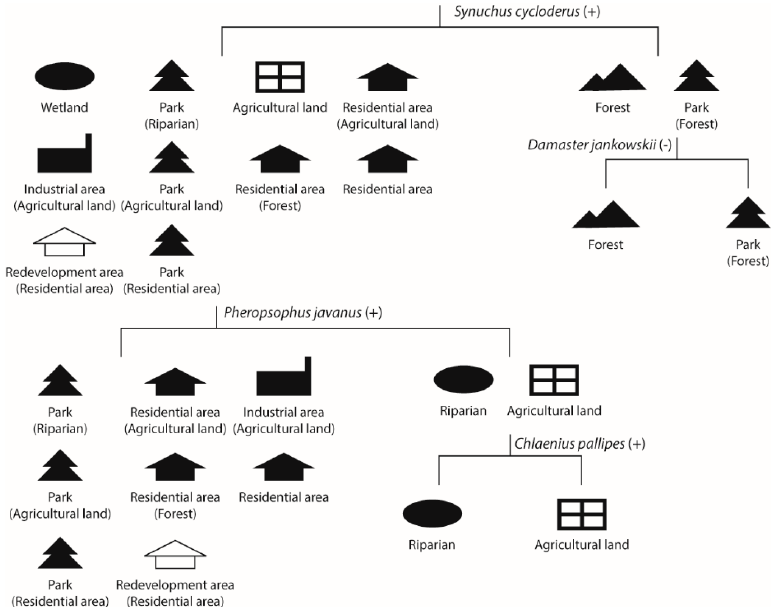
Figure 3. Two way indicator species analysis (TWINSPAN) classification of former and current land-use types. Indicator species are shown along the branches. Habitat types in the brackets are indicated as the former habitat types.